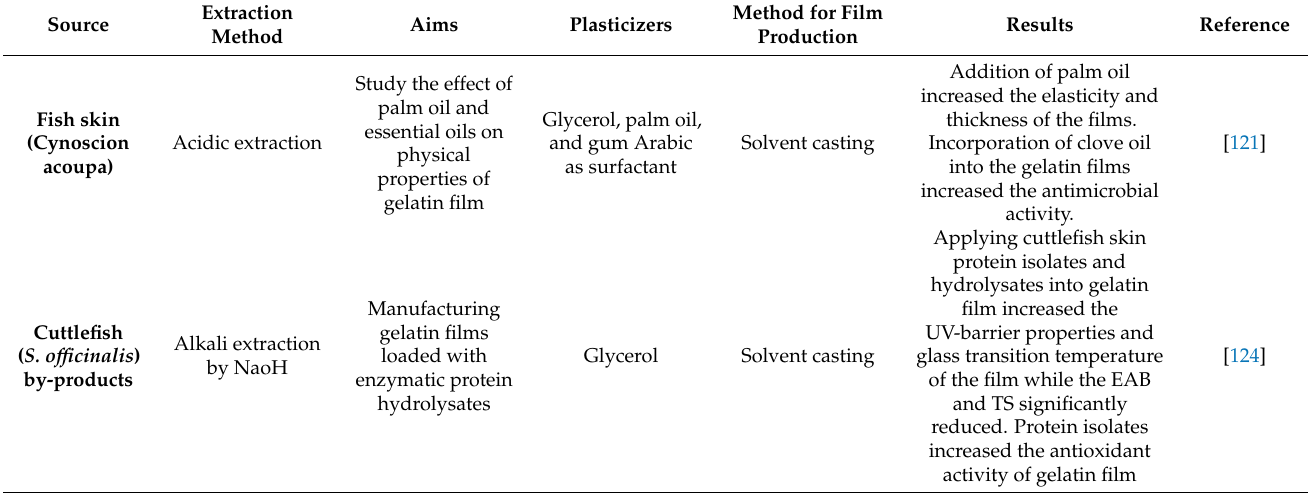
Table 3. Gelatin films developed from different animal by-product